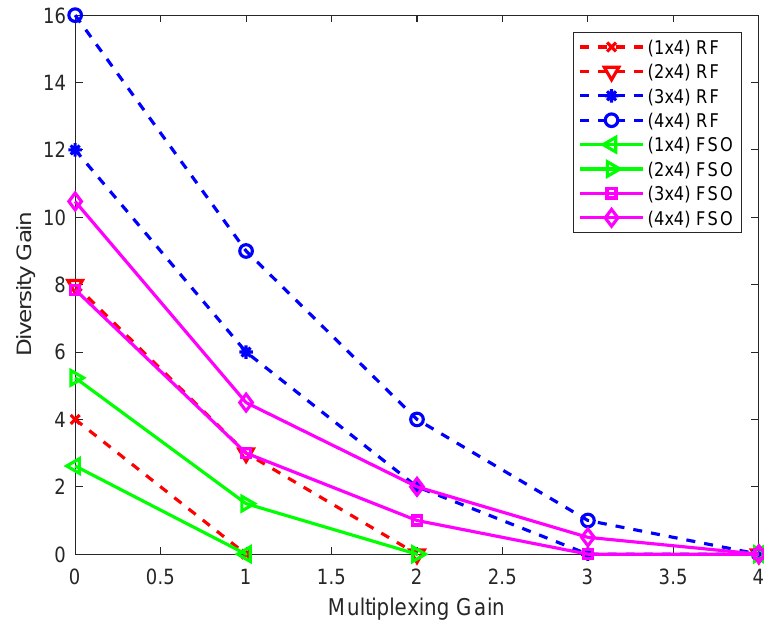
Figure 8. DMT of different MIMO configurations of RF link and FSO